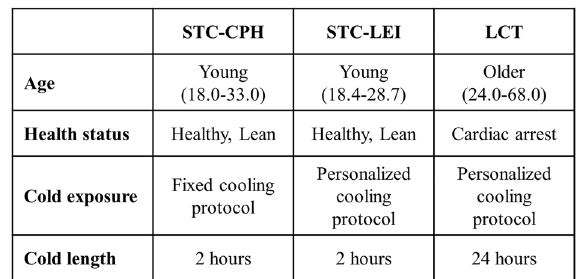
Figure 2. Overview of the three included studies and the difference in age, healt status, cold protocol, and exposure time. STC-CPH; short-term cold, Copenhagen. STC-LEI; short-term cold, Leiderdorp. LTC; long- term